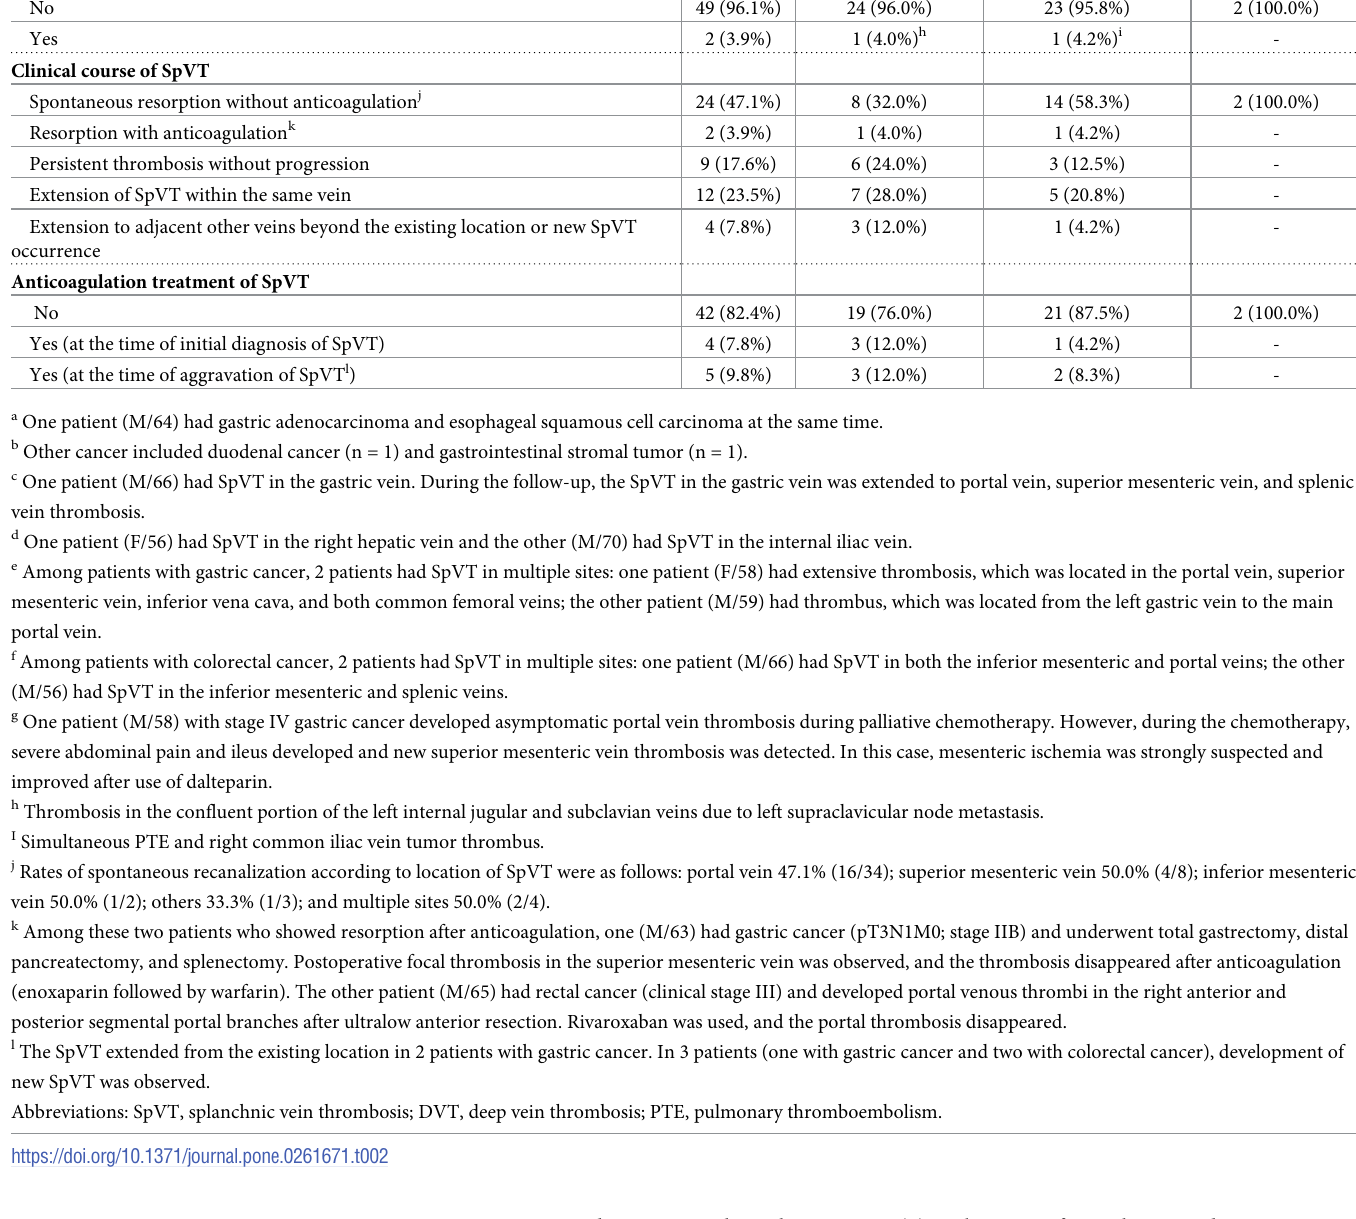
SpVT occurred in various clinical situations: (1) at the time of initial cancer diagnosis (15.7%); (2) at the time of tumor recurrence after curative therapy (7.8%); (3) postoperative period (27.5%); (4) during chemotherapy without evidence of tumor progression (21.6%); (5) during chemotherapy with the tumor progression [no clinical benefit from chemotherapy (19.6%)]; and (6) in the period of end-of-life care [terminal phase without further chemother- apy (7.8%)]. The majority of patients (90.2%) had no SpVT-related symptoms at the time of initial diag- nosis of SpVT, and most patients (96.1%) did not develop new SpVT-related symptoms